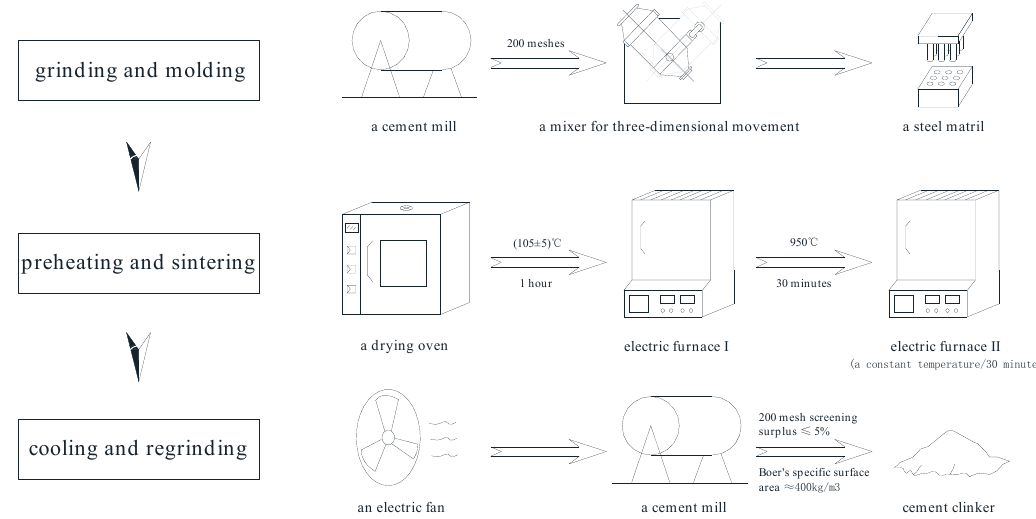
Figure 1. Processing diagram of cement clinker preparation.